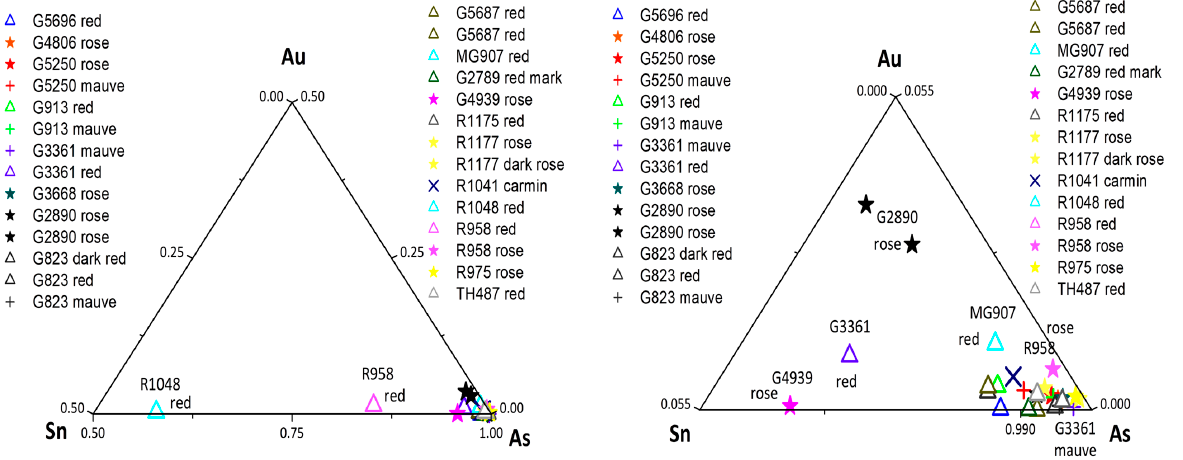
Figure 9. Comparison of the signal of elements associated with the use of gold.